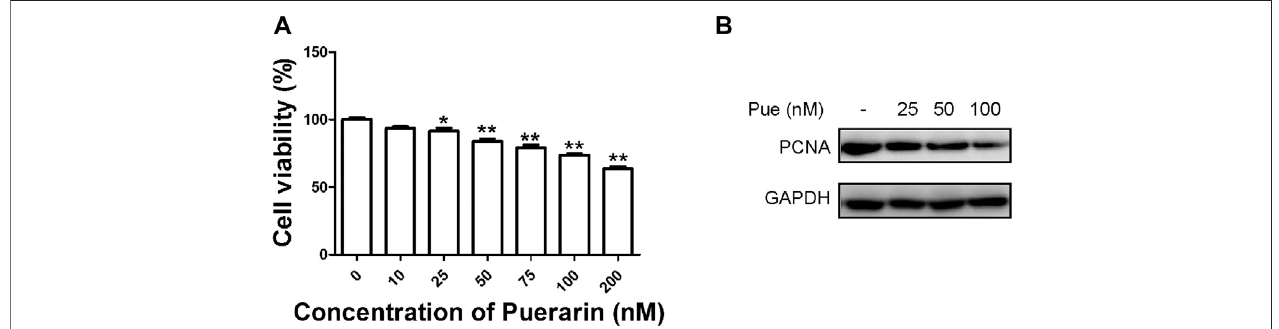
FIGURE 4 | Puerarin inhibited the proliferation of HPSCs. (A) Cell viability of HPSCs was tested by Cell Counting Kit-8 assay 48 h after treatment with puerarin. * p < 0.05, ** p < 0.01. (B) The protein expression levels of PCNA were tested in HPSCs after treatment with different doses of puerarin (25, 50, 100 nM) for 24 h by Western blotting analysis.